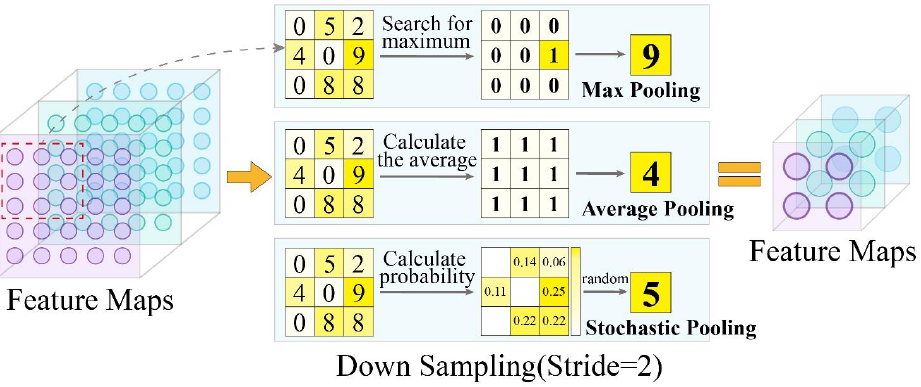
Figure 5. Process of traditional pooling methods, including max pooling, average pooling and stochastic pooling.